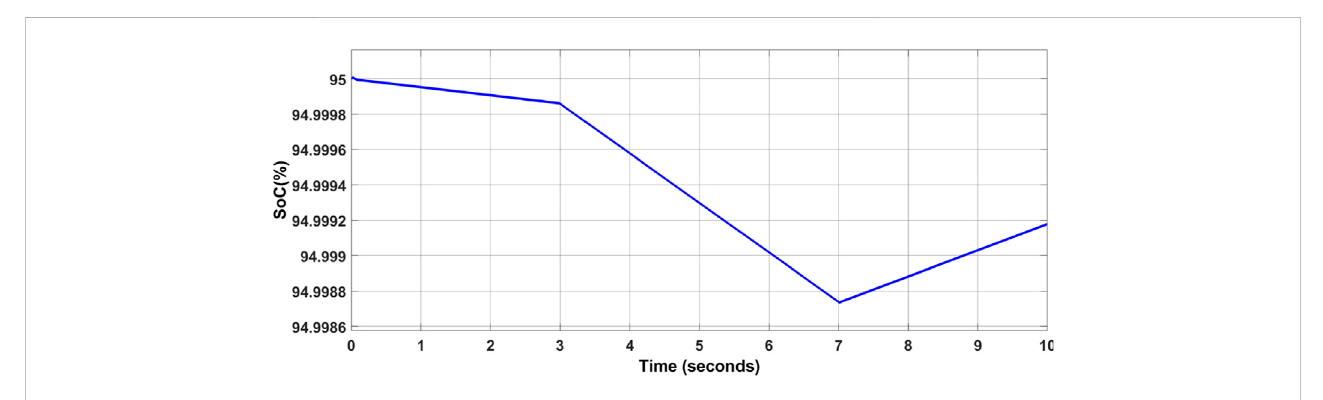
FIGURE 15 SOC of the battery under various values of the